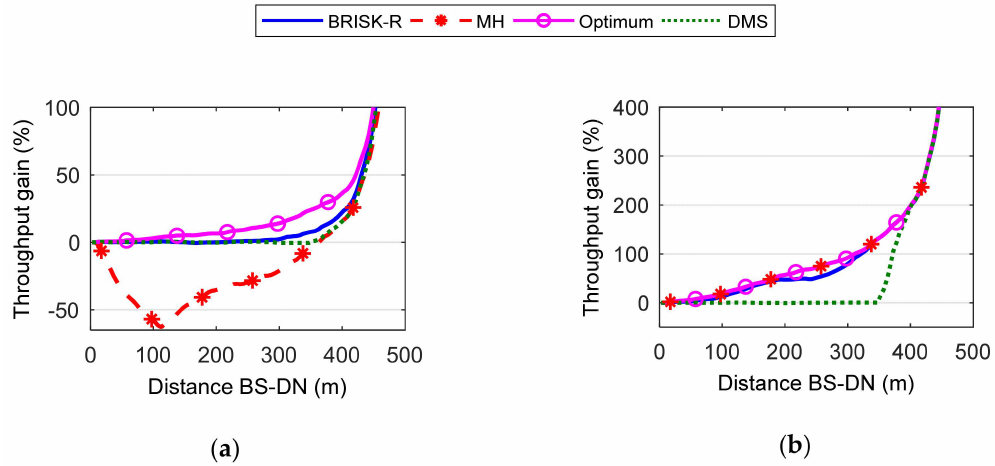
Figure 7. Throughput gain obtained with the mode selection schemes with respect to SH—web tra ffi c & homogeneous scenario. ( a ) 15 RN scenario; ( b ) 1000 RN